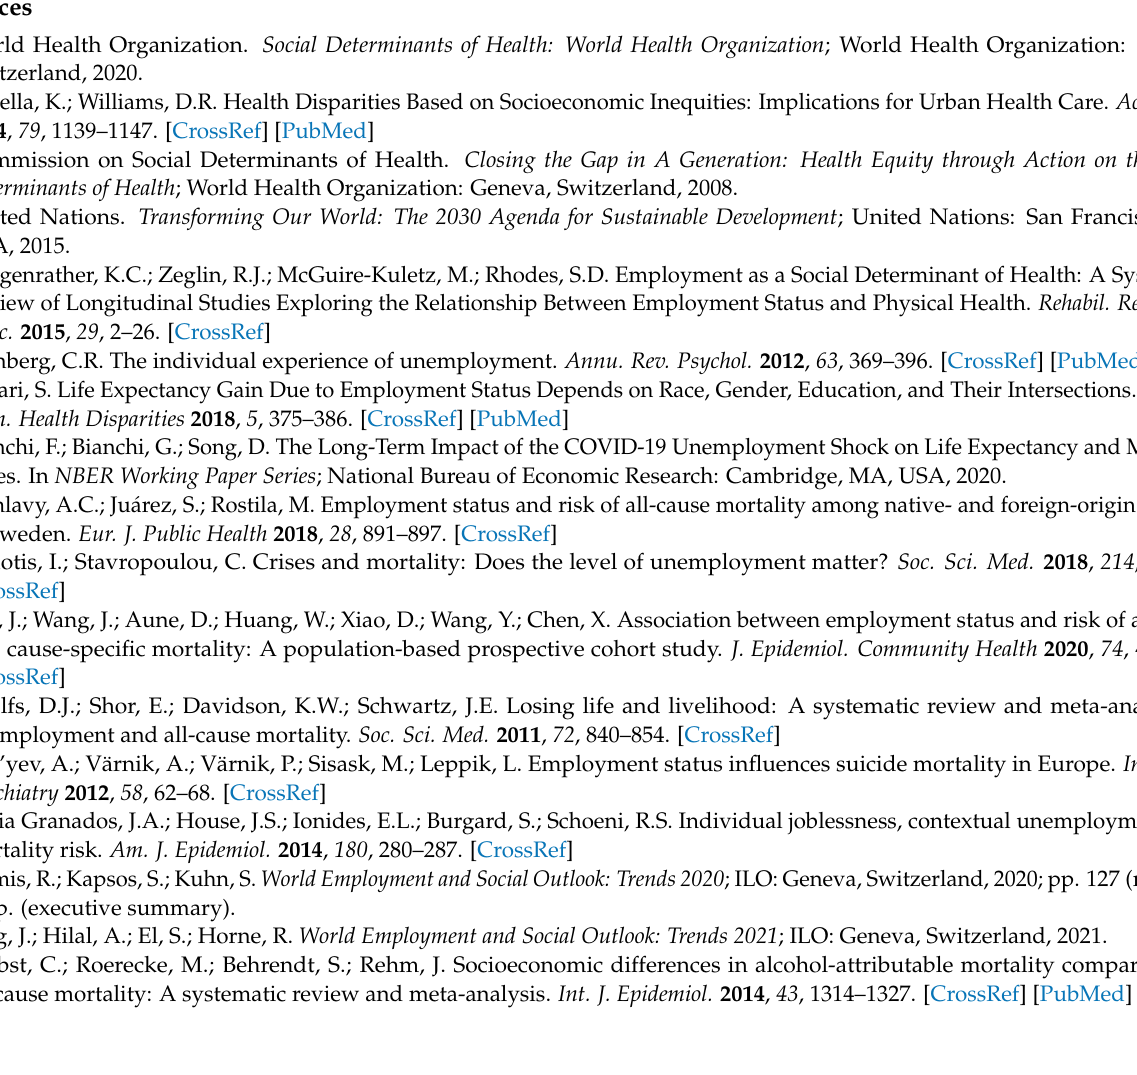
Table S2: Diagnoses and ICD-10 codes of 100% alcohol-attributable conditions; Table S3: Diagnoses and ICD-10 codes of conditions with an alcohol-attributable fraction > 10% for mortality globally; Table S4: Inclusion criteria; Table S5: Quality rating; Table S6: Quality checklist. Ratings on population representativeness of the sample, measurement of socioeconomic status (SES), operationalization of alcohol-attributable mortality, data linkage, and age-adjustment for each study included in the meta- analysis. Table S7: Causes of death included in each of the